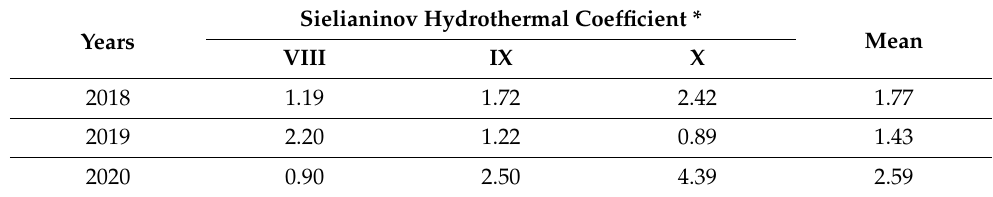
Table 1. Sielianinov hydrothermal coefficient during the summer-autumn development. Sielianinov Hydrothermal Coefficient * Years